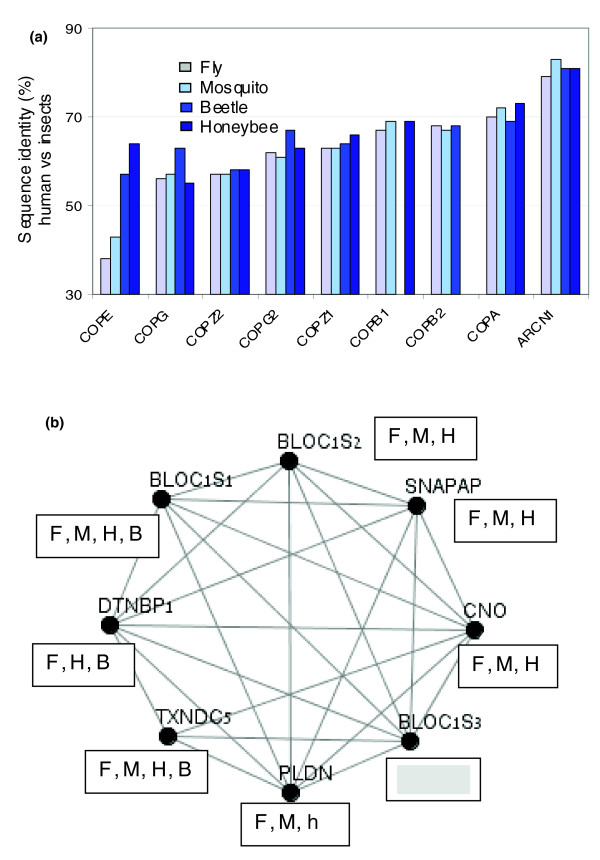
COP and BLOC interaction networks. (a) Sequence identity between human and insects of coatomer protein (COP)-1 proteins. The nine subunits of coatomer COP-1 are listed. The level of identity (%) between human and each of the four insect sequences is shown. The blue bars are color coded for the insect representatives as indicated. Note that for all proteins except CopE, the conservation level relative to the human ortholog is not different across the insects. Missing bars are due to missed annotations (as in Table 1 and Additional data file 3). (b) Biogenesis of lysosome-related organelles complex (BLOC)-1 in insects. The graph is based on confirmed interactions according to STRING scoring (see Materials and methods) for the eight subunits of mammalian BLOC-1. The identified homology to the fly (F), beetle (B), honeybee (H), and mosquito (M) are marked. Empty frame indicates no identified homologs in insects; small case letter indicates high sequence similarity that is only valid for a partial sequence. The interaction graph is based on identifying pair-wise interactions in BLOC-1. Information on individual subunits is available in Additional data file 2.